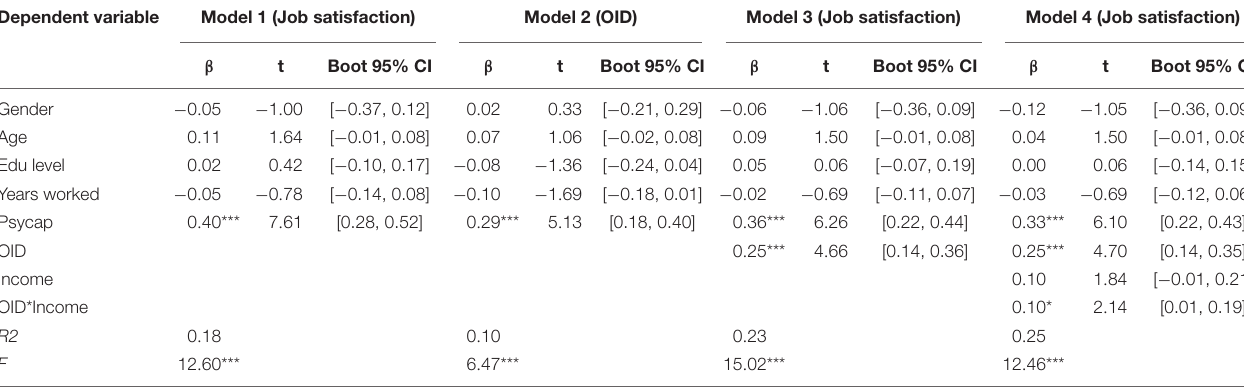
TABLE 3 | Hierarchical regression results.